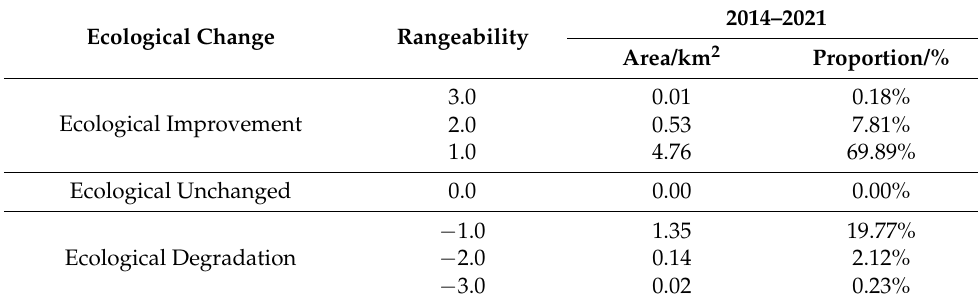
Table 3. Area and proportion of each ecological level in the study area.